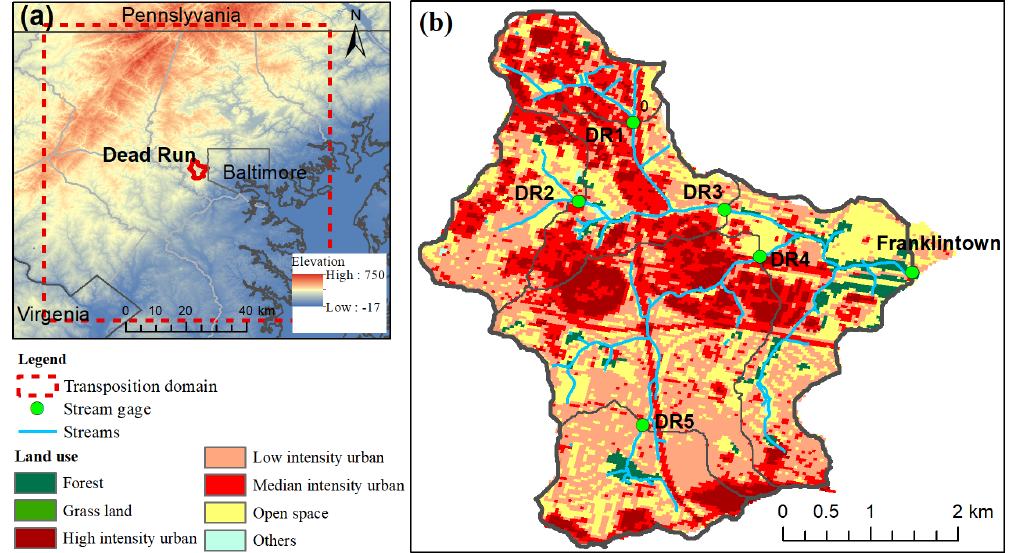
Figure 1. Overview of the Dead Run study region including (a) the location of DR, elevation and transposition domain of SST and (b) land use and land cover and stream gages. The red outline and grey outline in (a) indicate the boundary of the DR watershed and Baltimore City, respectively. Table 1. Characteristics of the Dead Run watershed (Smith et al., 2015). USGS ID